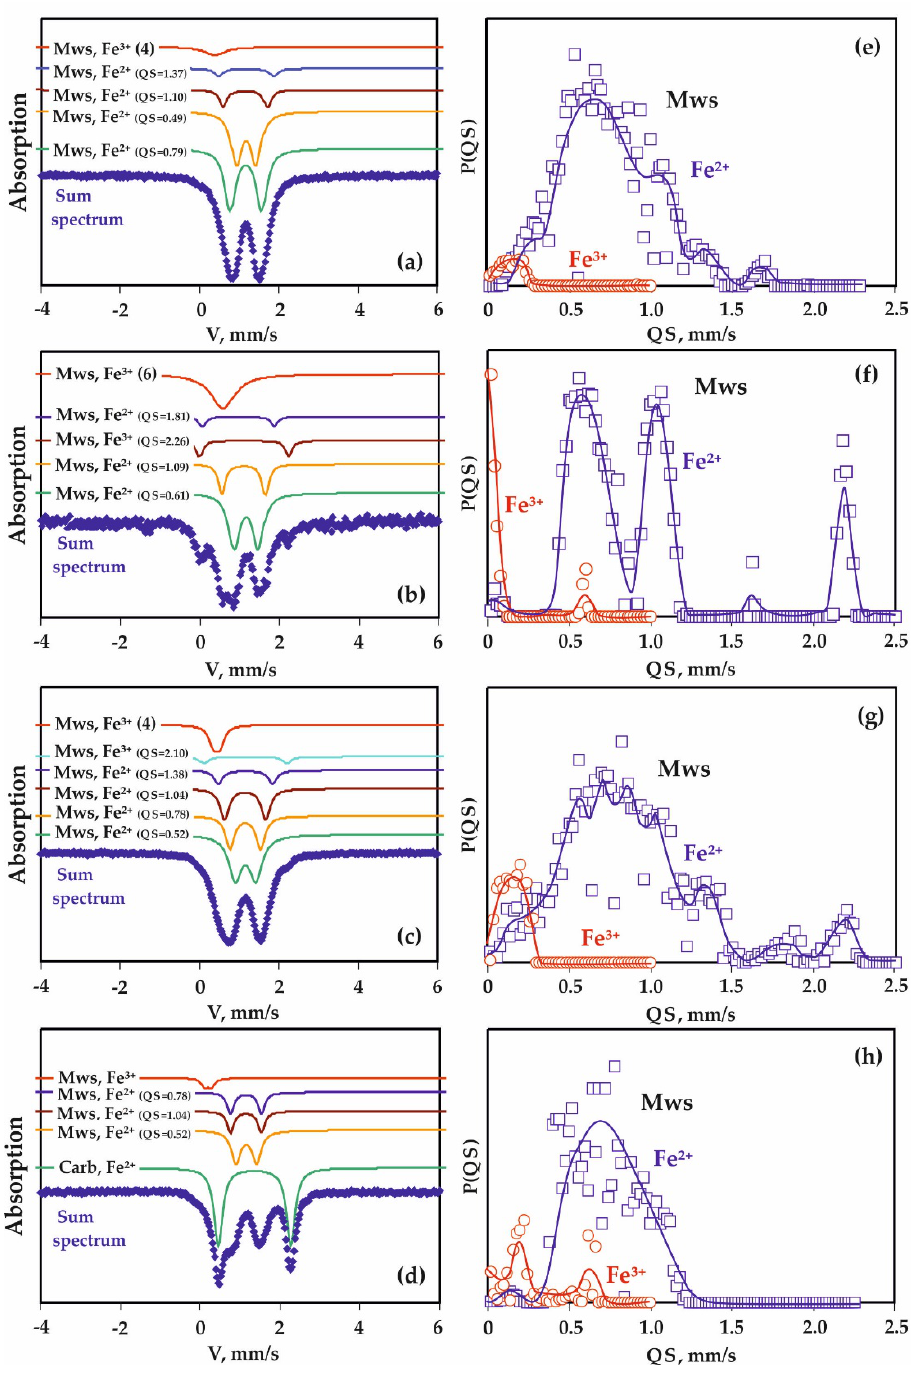
Figure 5. Mössbauer spectra of samples produced in the carbonate-iron system (exp. 1541 ( a,b,e,f ) and 1515 ( c,d,g,h )) as well as components of these spectra (a–d) and the probability distribution of quadrupole splittings P(QS) in experimental spectra of magnesiowüstite (e–h).